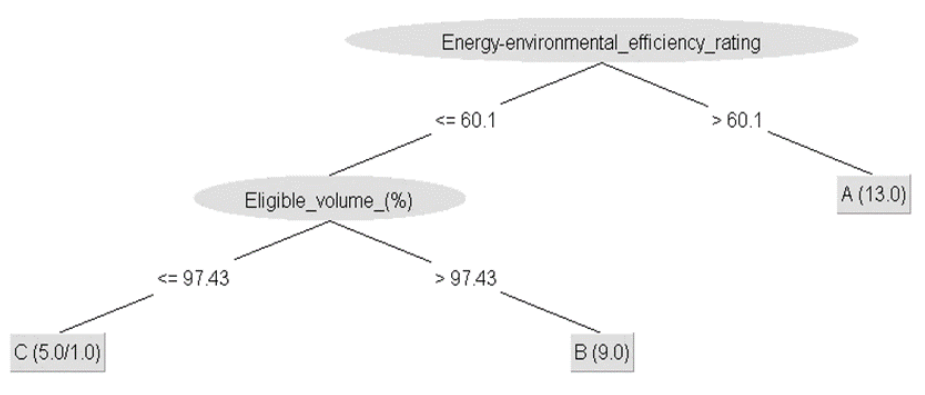
Figure 5. Decision tree for the energy-environmental level classification of biofuels using the Resample filter. GO, Goiás; SP, São Paulo; MS, Mato Grosso do Sul.